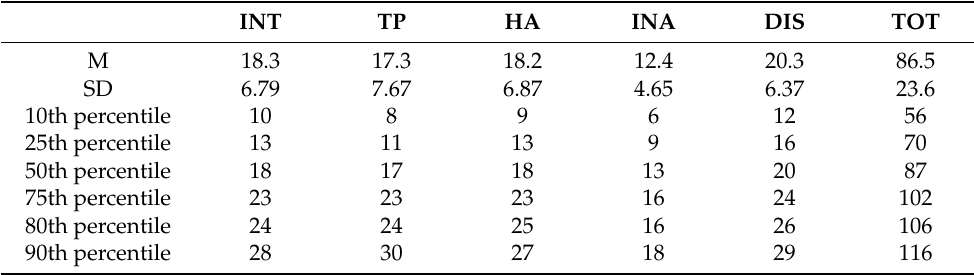
Table 6. Descriptive indexes of the final version of the MSBS.